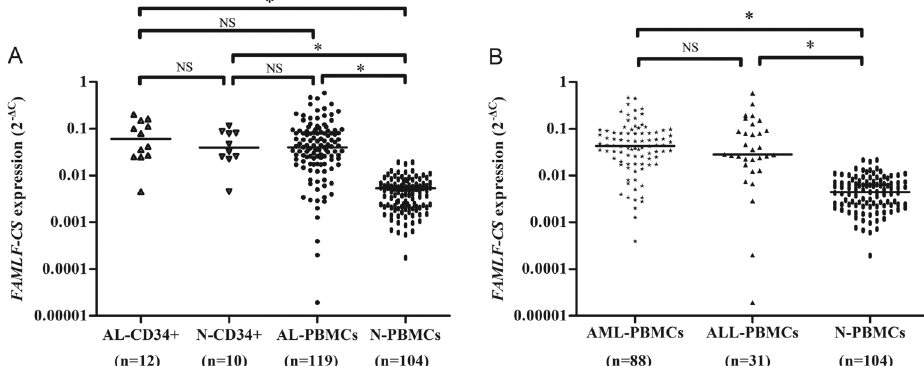
Figure 3. RQ-PCR analysis of FAMLF-CS expression in CD34 + cells and peripheral blood mononuclear cells (PBMCs) from acute leukemia (AL) patients and normal healthy controls (N). A , Expression of FAMLF-CS in CD34 + cells and PBMCs from AL patients and normal healthy controls. B , Expression of FAMLF - CS in PBMCs from patients with acute myeloid leukemia (AML), acute lymphocytic leukemia (ALL), and normal healthy controls (N). Data of the relative quantitation of FAMLF-CS expression are reported as 2 - D C . Horizontal bars represent the median FAMLF-CS expression for each group. *P o 0.05 between groups (Nemenyi test). AL-CD34 + : CD34 + cells from AL patients; N-CD34 + : CD34 + cells from normal healthy controls; AL-PBMCs: PBMCs from AL patients; N-PBMCs: